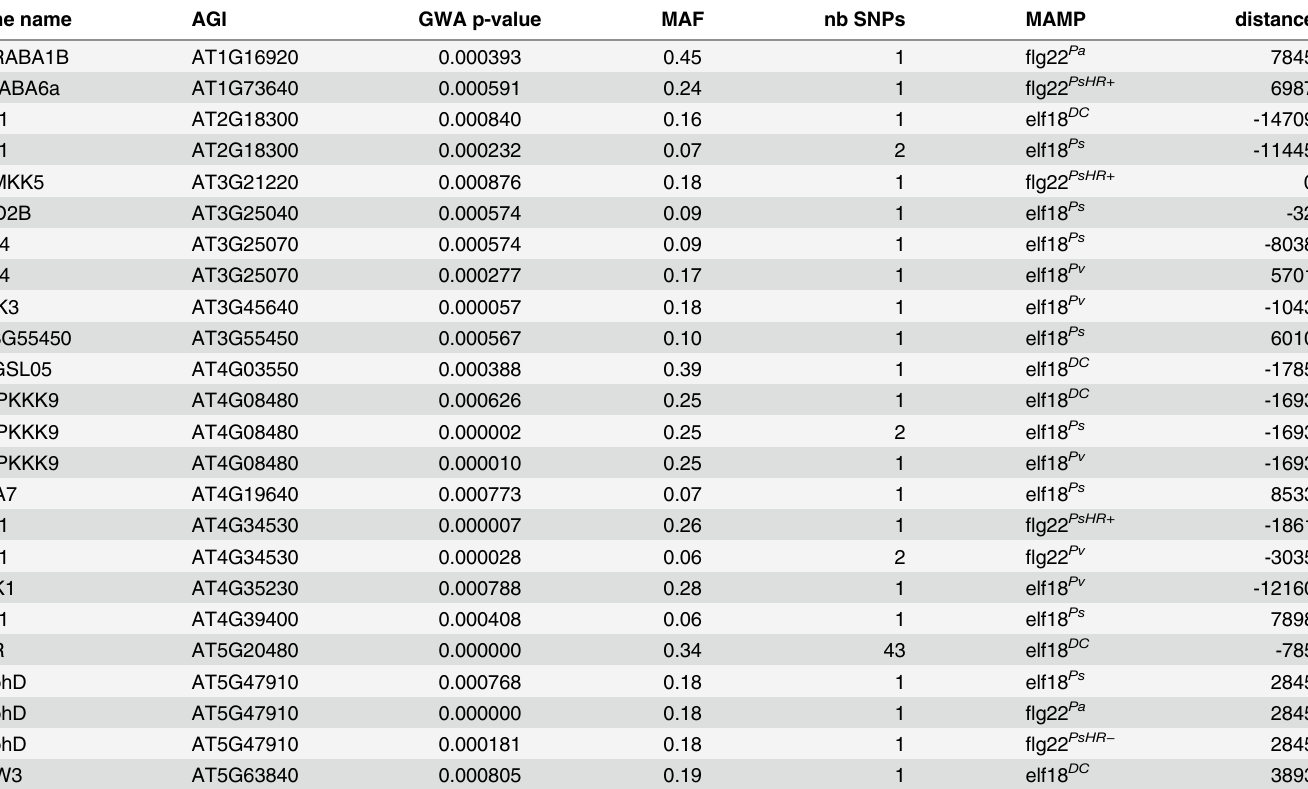
Table 1. A priori candidate genes that statistically associate with natural variation in seedling growth inhibition. Candidate genes were identified within 15 kb around a SNP falling in the 0.1% tail of EMMAX p -values. The distance of the candidate locus and the highest associate SNP are indicated in bp (column